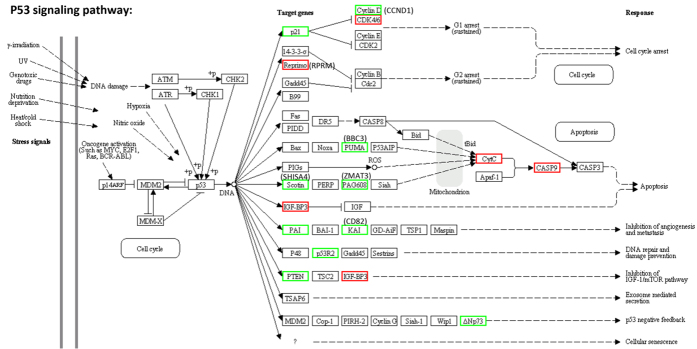
Gene expression for a subset of genes in the p53 signaling pathway was impaired by hOXR1 depletion under physical conditions.The p53 pathway is adapted from KEGG database. The up-regulated genes are labeled in red, while the down-regulated genes are labeled in green.